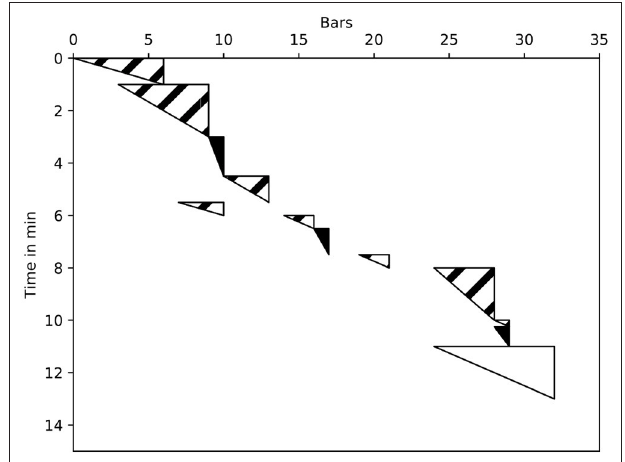
FIGURE 1 | Distribution of musical material and subject’s activity in time; illustration based on Miklaszewski (1989).